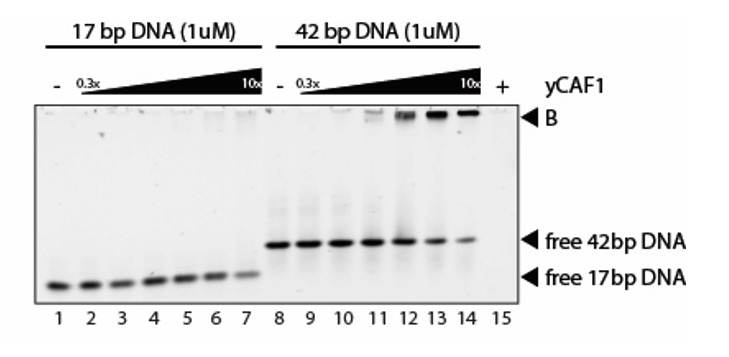
DOI:
http://dx.doi.org/10.7554/eLife.23474.025